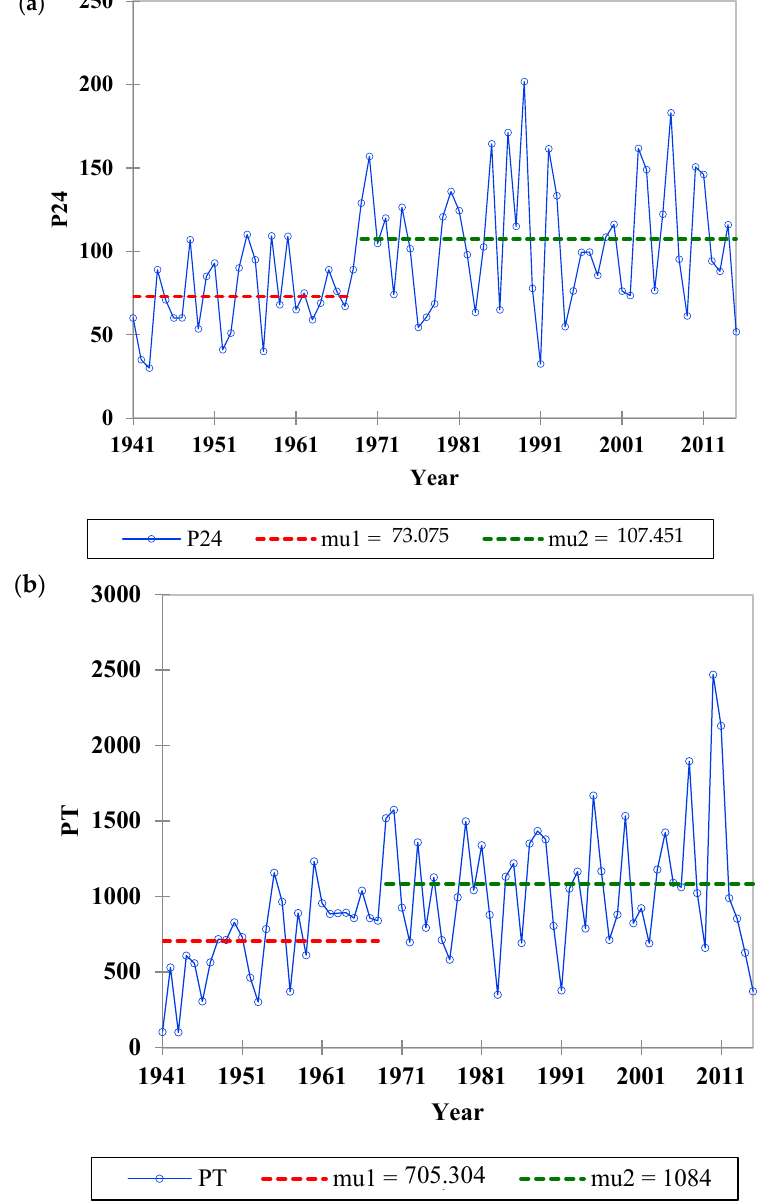
Figure 4. Results of the Buishand test for ( a ) P24 and ( b ) PT.